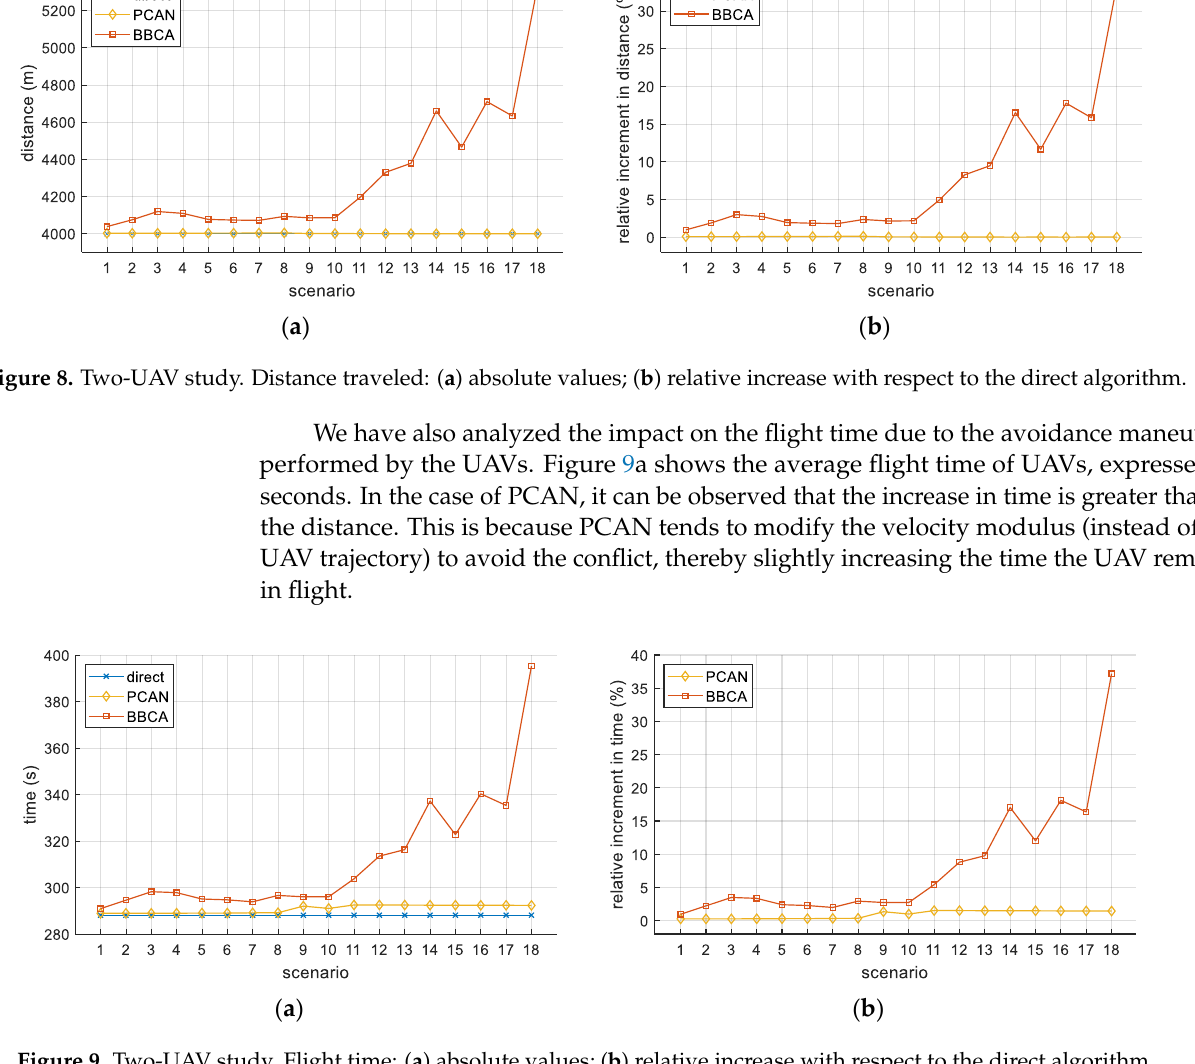
Figure 9. Two-UAV study. Flight time: ( a ) absolute values; ( b ) relative increase with respect to the direct algorithm.